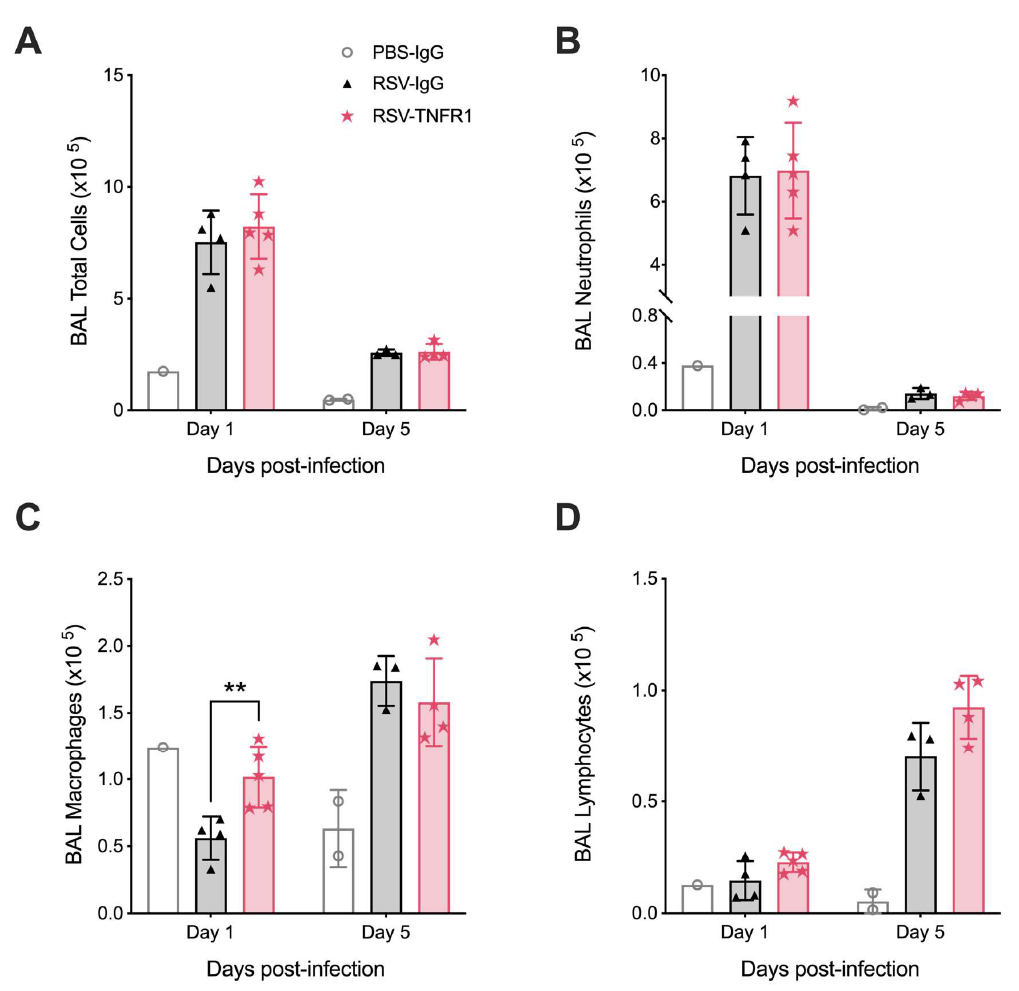
Figure 8. Post-infection blockade of TNFR1 improves macrophage cell counts in the BALF of RSV infected mice. At days one and five p.i., BALF was collected and used to obtain ( A ) total cell counts, as well as di ff erential cell counts consisting of ( B ) macrophages, ( C ) lymphocytes, and ( D ) neutrophils. Data are expressed as mean ± SD and is representative of one experiment. Significant results as compared to the respective control are marked with asterisks (** p ≤